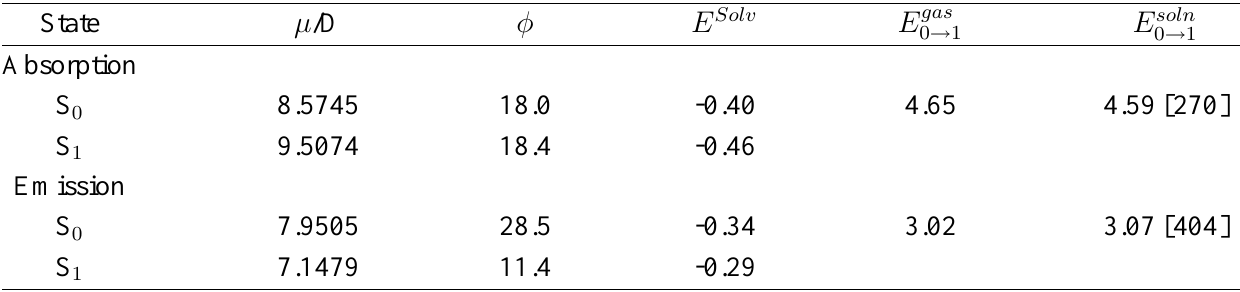
Table 3. S and S dipole moments, solvation energies and vertical transition energies (energies are in 0 1 eV). The emission data are from the CIS/6-311G(d,p) optimized